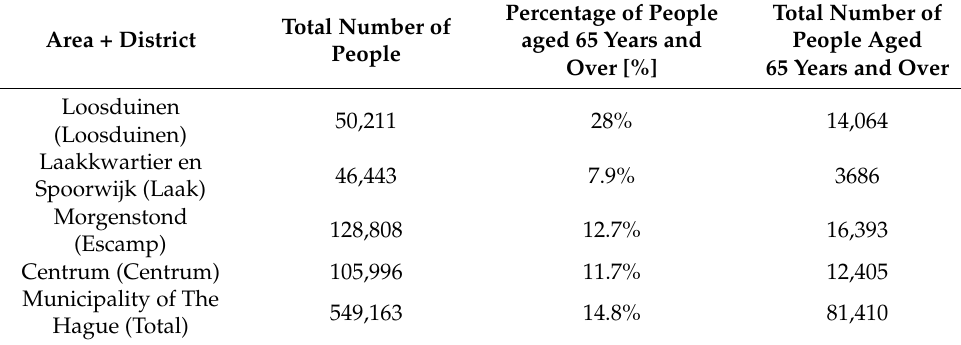
Table 1. Population of The Hague and its districts (on 1 January 2021) according to DHIC/Gemeente Den Haag/Dienst Publieke Zaken (https://denhaag.incijfers.nl/jive) (accessed on 23 January 2022). Percentage of People Total Number of Total Number of Area + District aged 65 Years and People Aged People Over [%] 65 Years and Over Loosduinen 50,211 28% 14,064 (Loosduinen) Laakkwartier en 46,443 7.9% 3686 Spoorwijk (Laak) Morgenstond 128,808 12.7% 16,393 (Escamp) Centrum (Centrum) 105,996 11.7% 12,405 Municipality of The 549,163 14.8% Hague (Total)